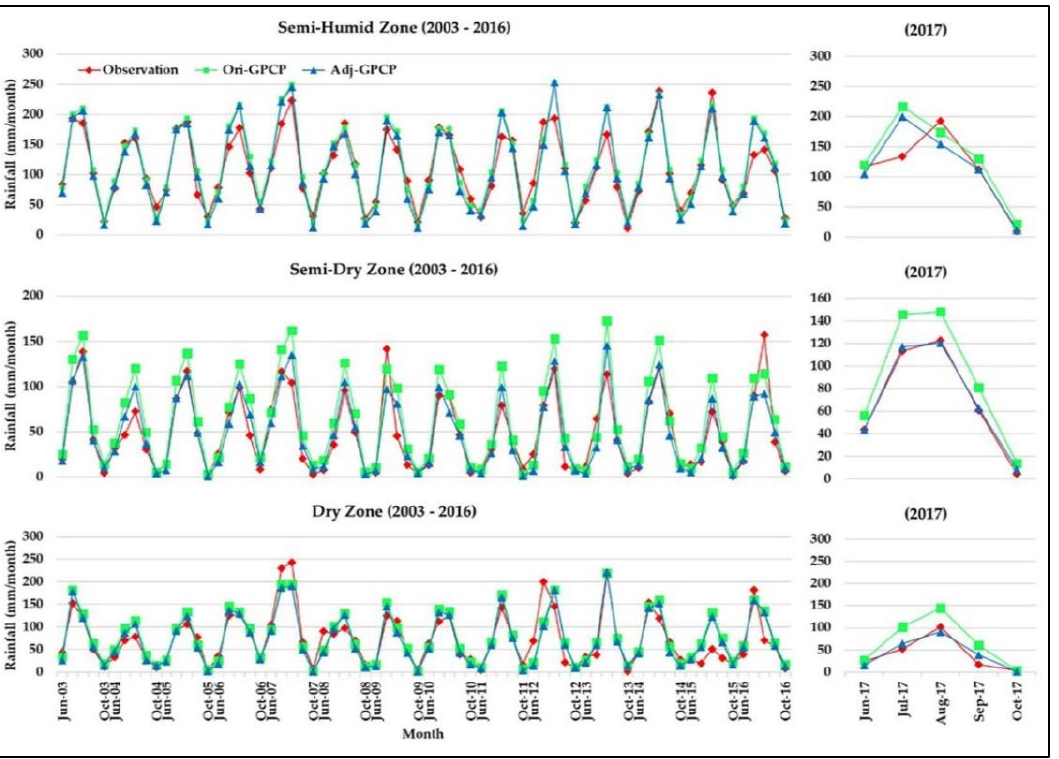
Figure 8. The areal mean monthly rainfall series for gauge observations, Ori-GPCP, and Adj-GPCP.